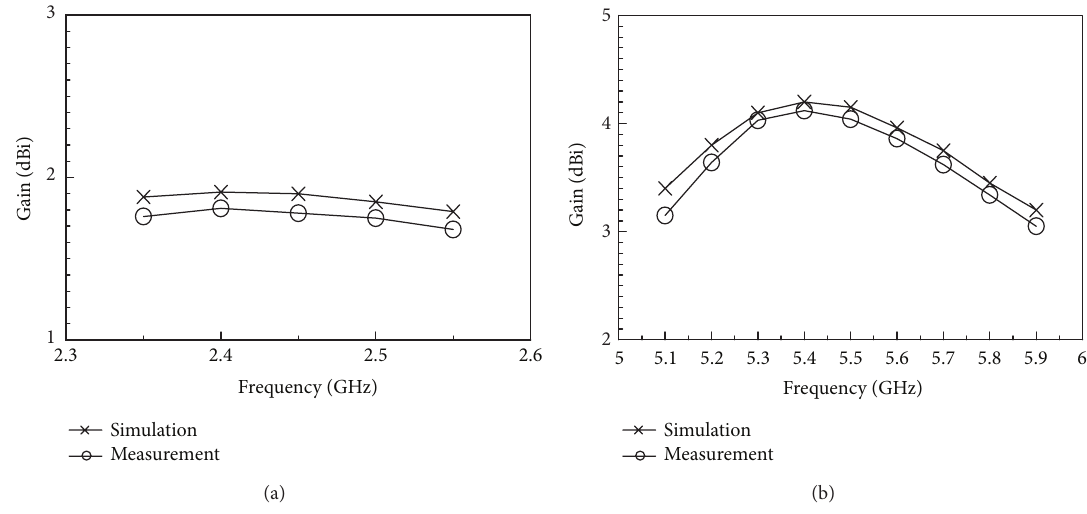
Figure 8: Simulated and measured antenna peak gain values versus frequency at (a) 2.35–2.55 and (b) 5.1–5.9 GHz of proposed